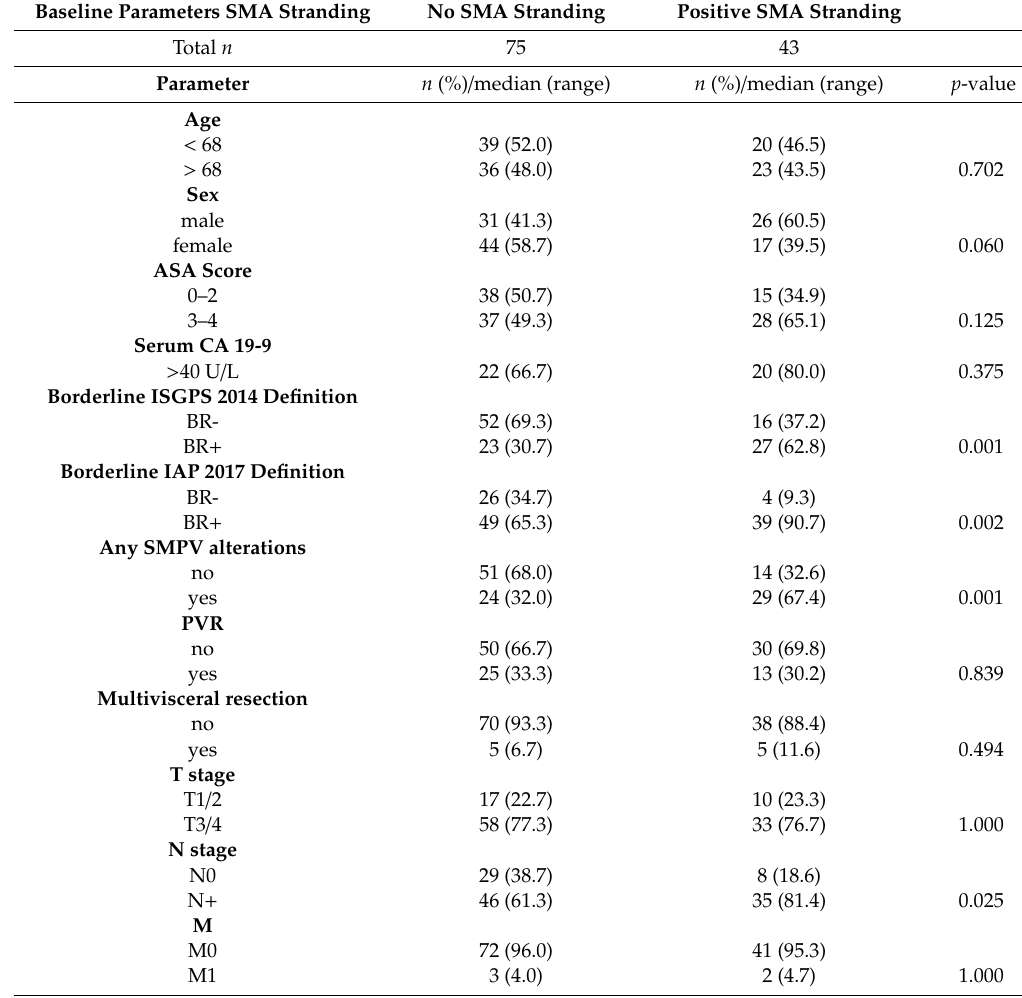
Table 1. Baseline parameters in patients with superior mesenteric artery (SMA) stranding versus no SMA